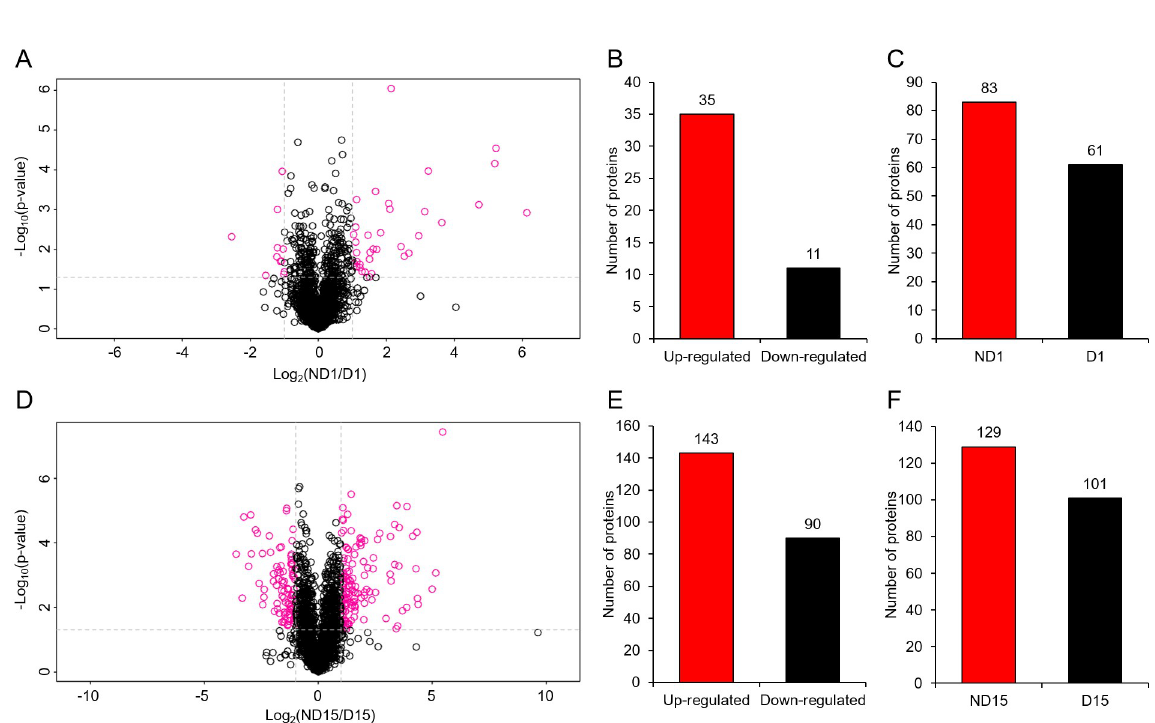
Fig 3. Comparisons of protein expression patterns between non-diapause-(ND) and diapause-destined (D) pupae of Bactrocera minax . (A-C) Differentially abundant proteins (DAPs) in ND1 vs D1 comparison. (D-F) DAPs in ND15 vs D15 comparison. (A and D) Volcano plot of log 2 fold-change vs -log 10 p value in each comparison. Fold change > 2 and p < 0.05 were set as the threshold for significant differential abundance. (B and E) Number of proteins that were detected in both ND and D groups with significantly different abundance. (C and F) Number of proteins that